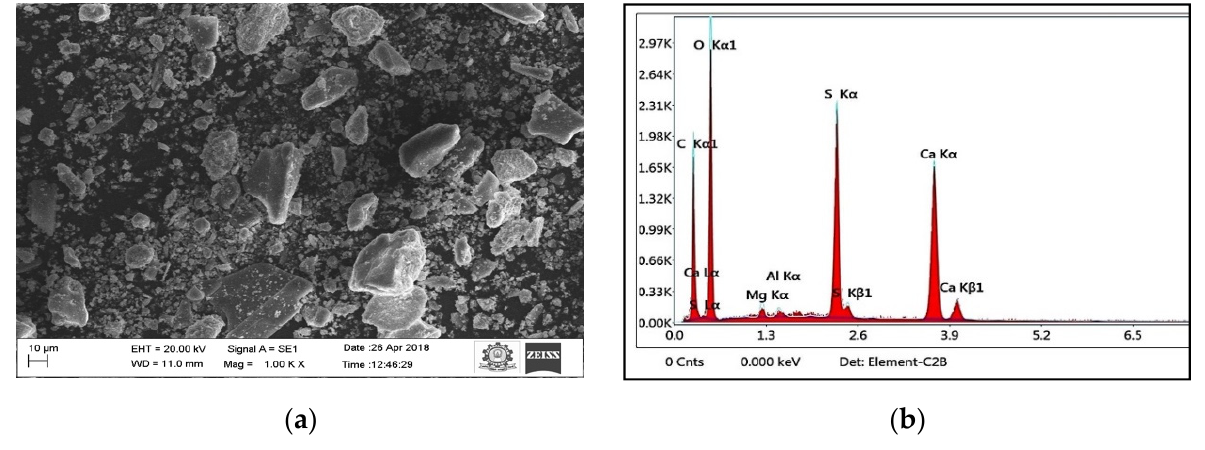
Figure 5. ( a ) SEM image of Gypsum; ( b ) EDAX image of Gypsum.